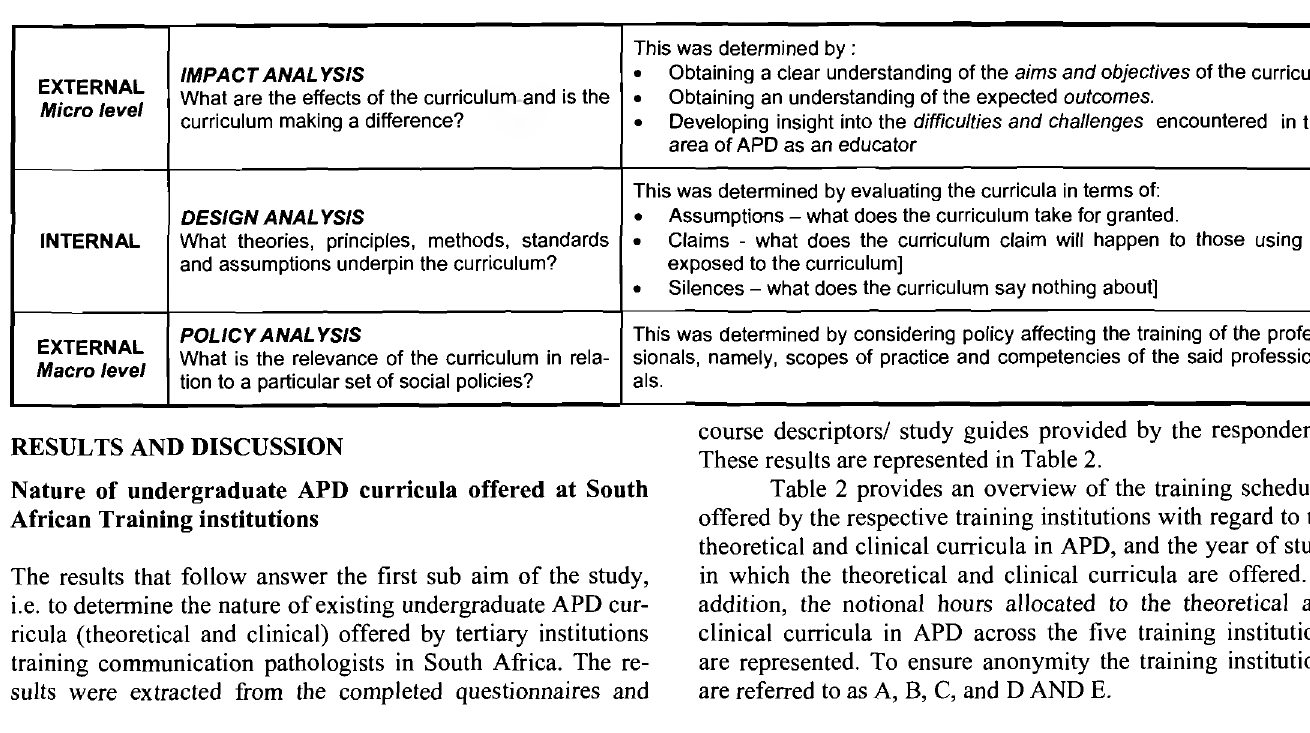
Table 1: A framework for the analysis of a curriculum (Jansen & Reddy, 1998, p.6) Adapted to the current study.